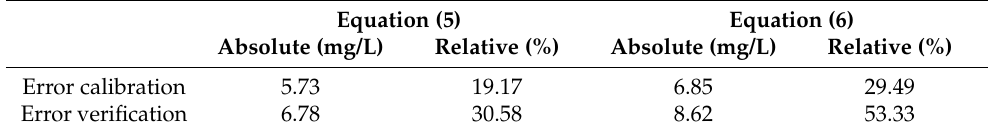
Table 4. Errors of models with IR and RGB at 90 ◦ .